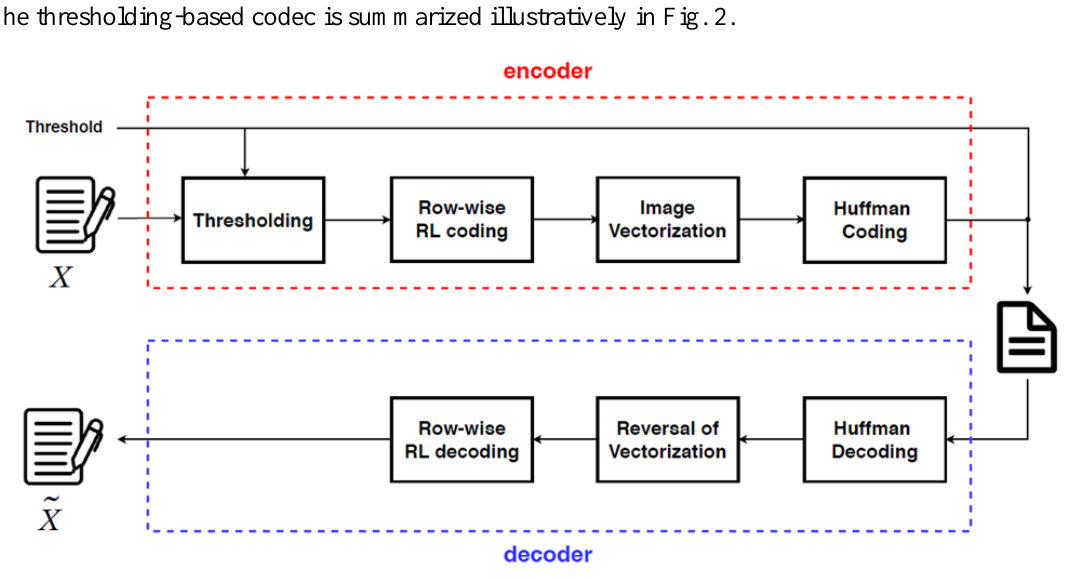
Figure 2. Framework of the thresholding-based